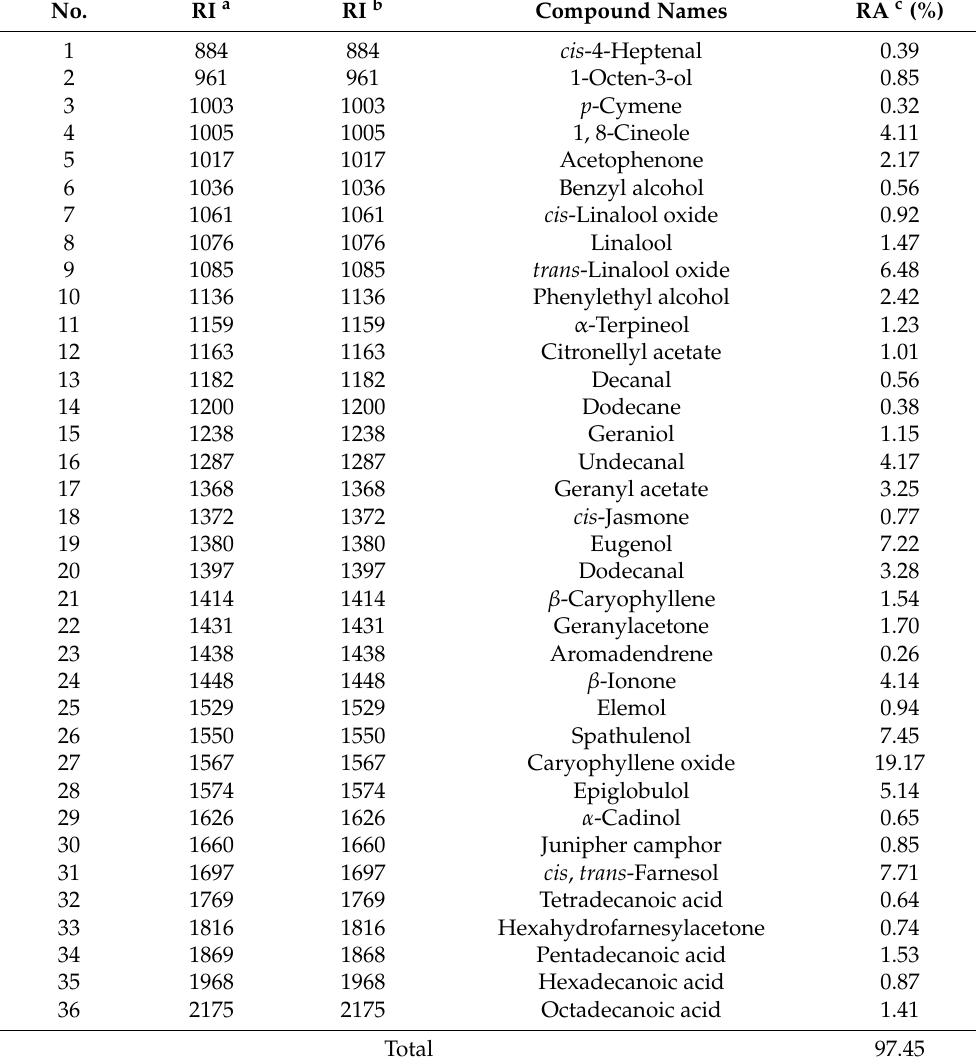
Table 2. Chemical composition of the essential oil from the flower buds of L. japonica . No. RI a RI